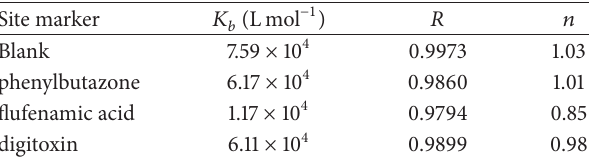
Table 3: Binding constants of competitive experiments ( 𝑇 = 302 K, = 280 𝜆 ex